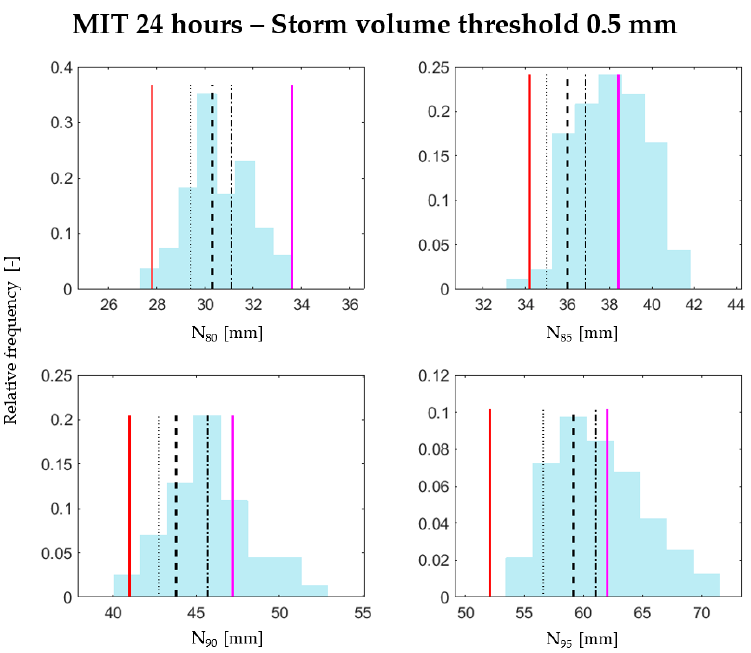
Figure 6. Relative frequency of volumetric percentiles that treat a percentage of the total number of rainfall events, for MIT 24 h and storm volume threshold 0.5 mm. Red and magenta lines represent respectively observed rainfall series with time-step 15 min and 24-h. Black dashed, dotted and dash-dotted lines represents respectively the median, 25th and 75th percentiles of simulated data (light cyan histograms).